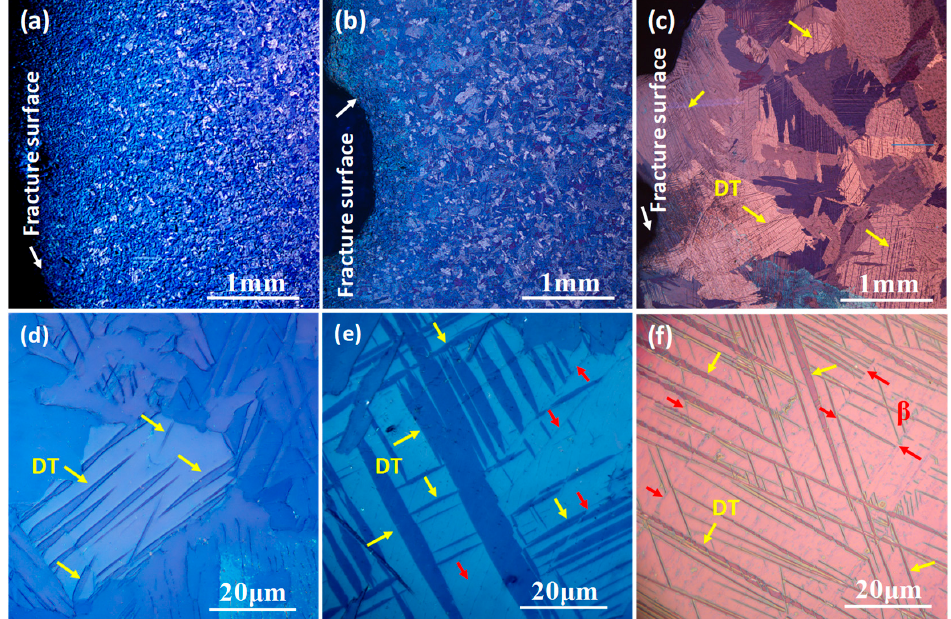
Figure 5. Polarized optical microstructures of TA3 alloy with different grain size characteristics after impact deformation. ( a – c ) are the low-magnification images near the fracture surface of FG Ti, MG Ti and CG Ti, respectively. ( d – f ) are the corresponding high-magnification image.